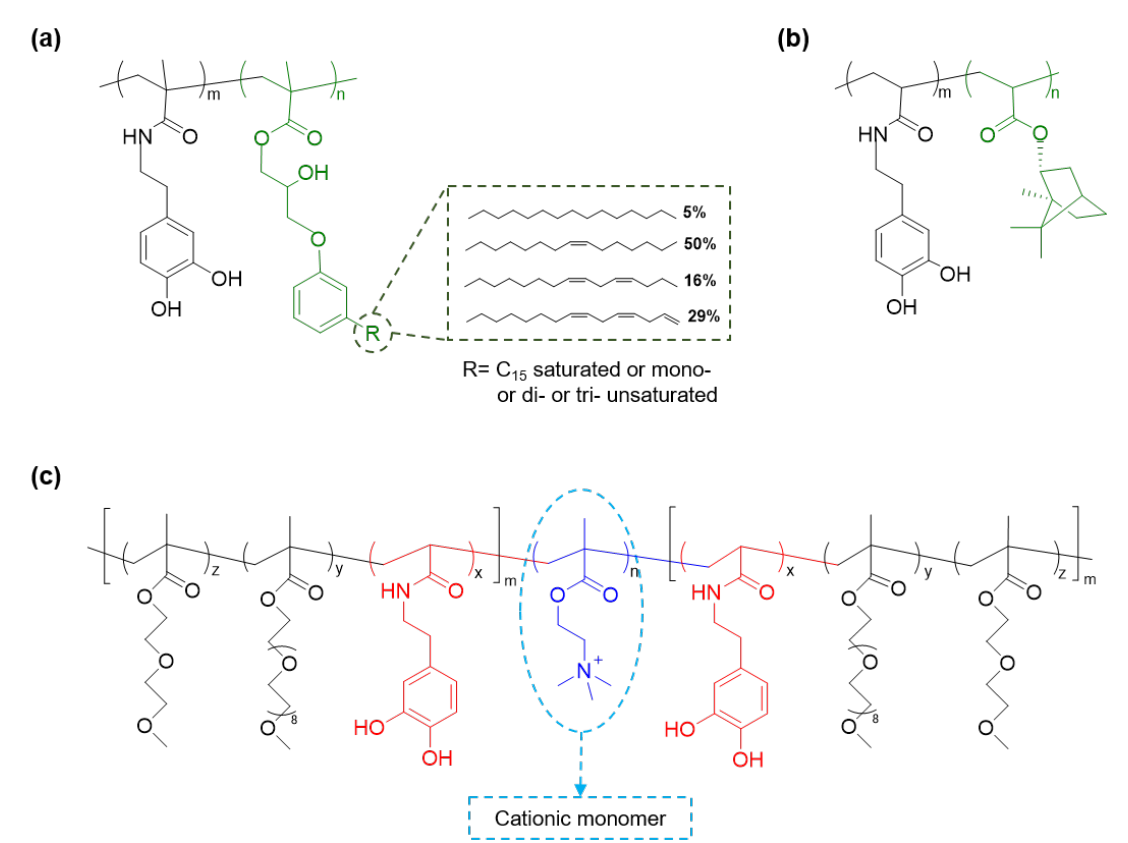
Figure 2. Chemical structures of polymers functionalized with catechol-based and antimicrobial monomers ( a ) P(DMA- co -HCPM), ( b ) P(DMA- b -BA), and ( c ) P(MEO 2 MA- co -OEGMA- co -DAA)- b -PMETA- b -P(MEO 2 MA- co -OEGMA- co -DAA).